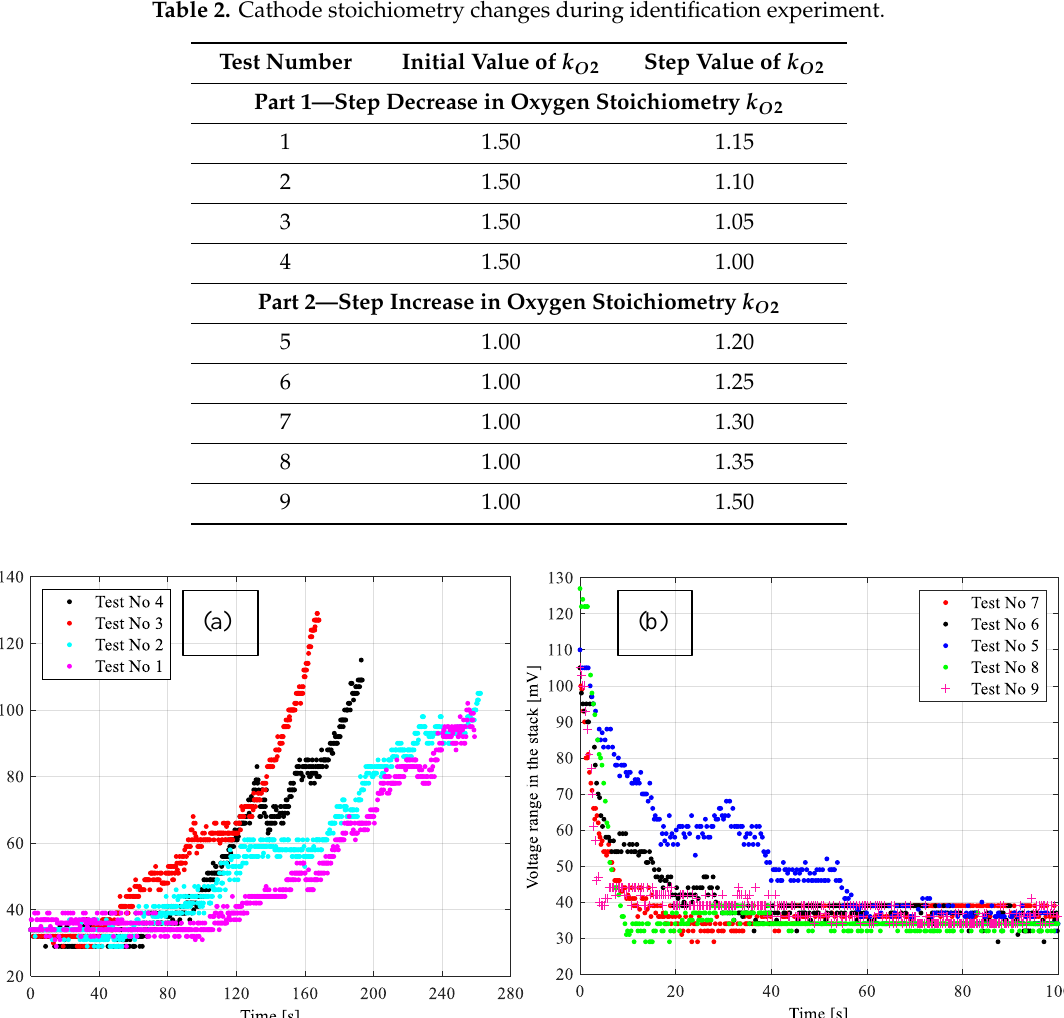
Table 2. Cathode stoichiometry changes during identification experiment.